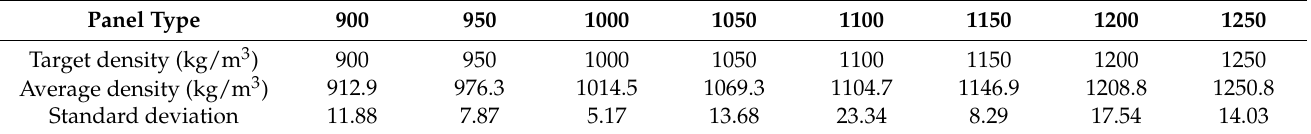
Table 2. Target and average density and standard deviation of the experimental panels.